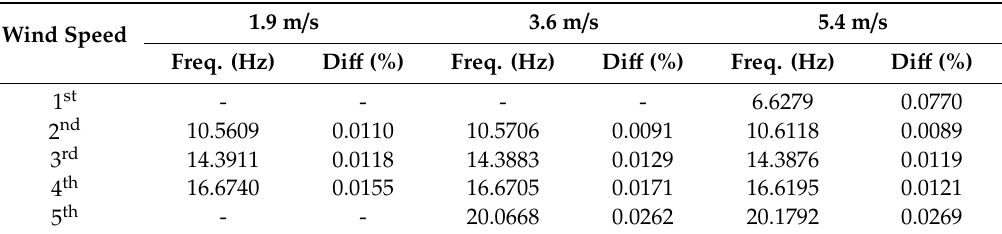
Table 1. Tower modal frequencies and damping ratios at different wind speeds.